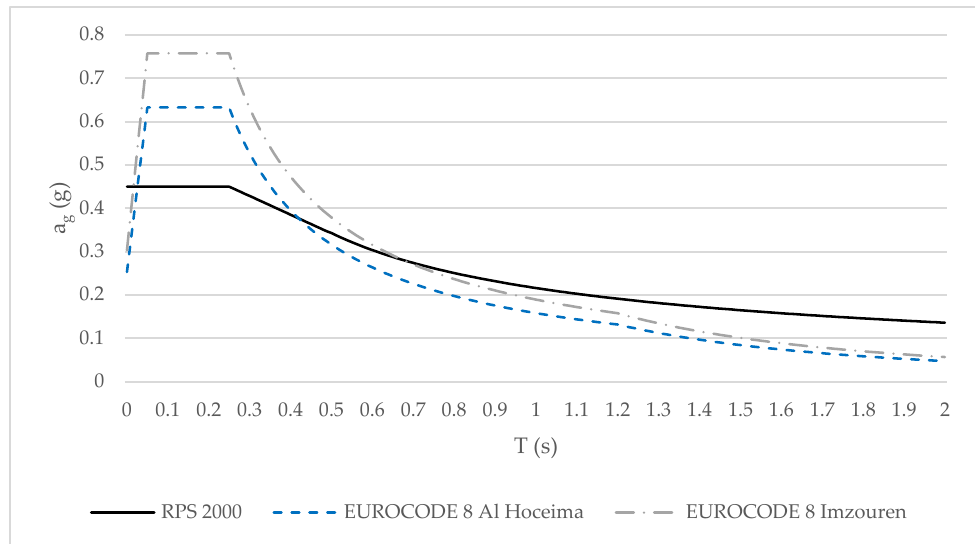
Figure 3. The 5% elastic response spectra for the probabilistic scenario expected on outcrop rock. As for the other types of soil, Table 3 shows that both seismic standards introduce the same soil classification. Figures 4 and 5 show soil distribution in the towns of Al Hoceima and Imzouren, respectively. The soil type will undoubtedly come into play in the evaluation of seismic risk between the two cities. The structures of Al Hoceima are mostly built on firm or rocky ground, while the structures of Imzouren are mostly built on relatively soft soils. All of the response spectra for each soil type are shown in Figure 6.